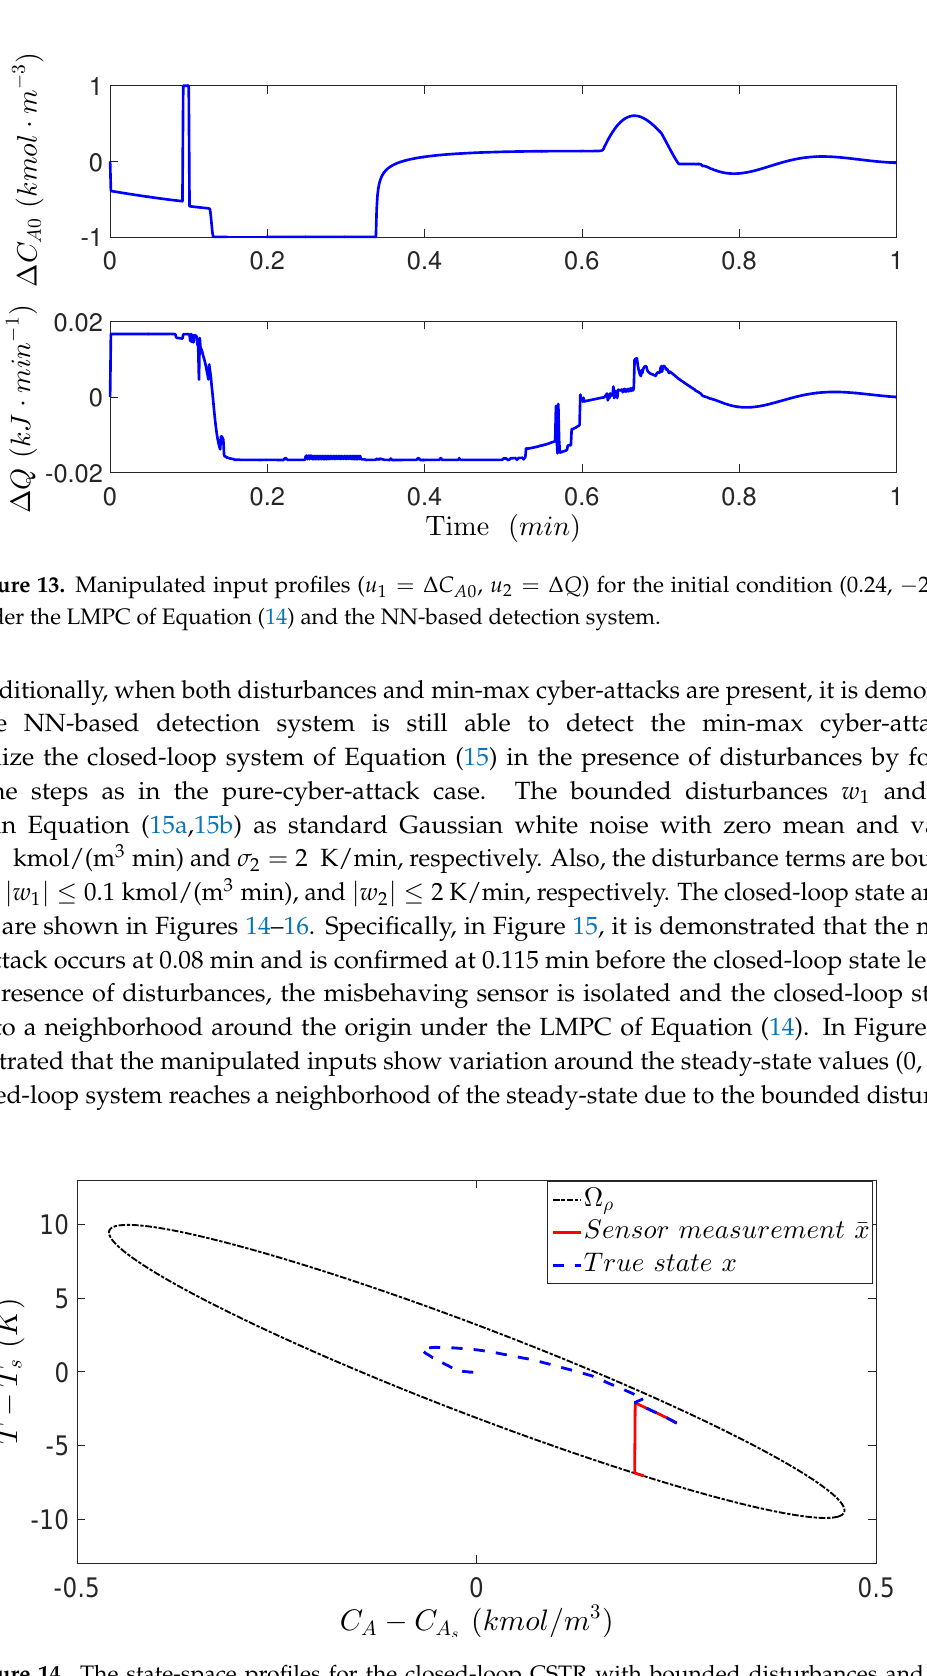
Figure 14. The state-space profiles for the closed-loop CSTR with bounded disturbances and the initial condition (0.25, − 3), where a min-max attack is detected by the NN-based detection system and mitigated by the LMPC of Equation